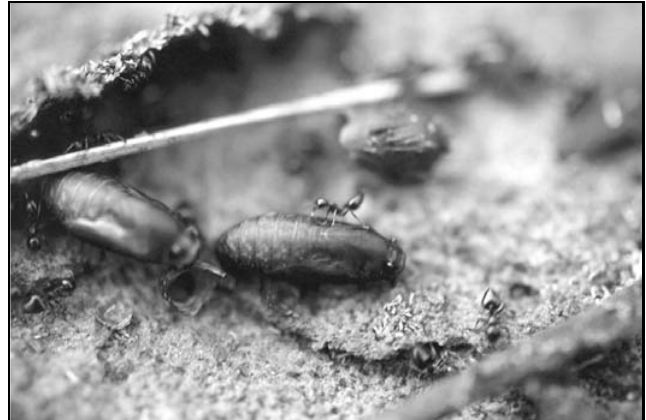
Fig. 1. Wall of ant nest with pupae and attendant Crematogaster liengmei